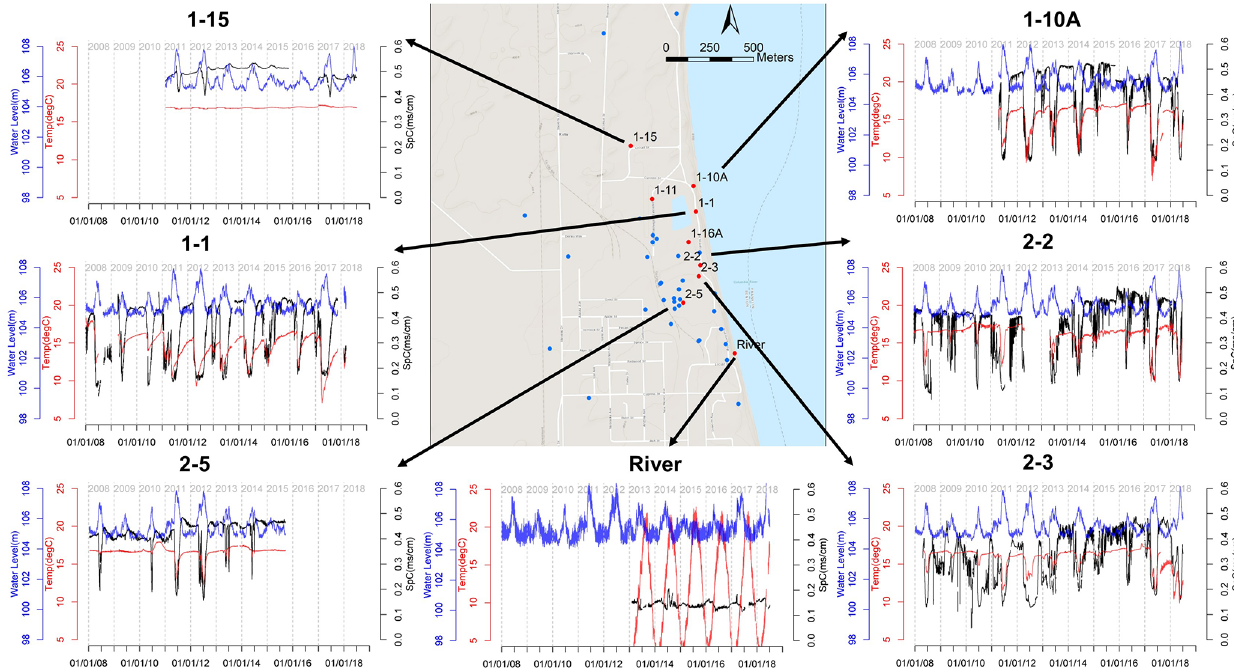
Figure 1. Groundwater monitoring well network in the 300 Area of the Hanford site and the monitoring data at select wells. Each dot represents a well instrumented to measure groundwater elevation, temperature, and specific conductance (SpC). The wells selected for this study are marked with red dots with well names. The three variables monitored are shown in time-series plots using blue (water elevation), black (SpC), and red (temperature) lines. (Base map © Google